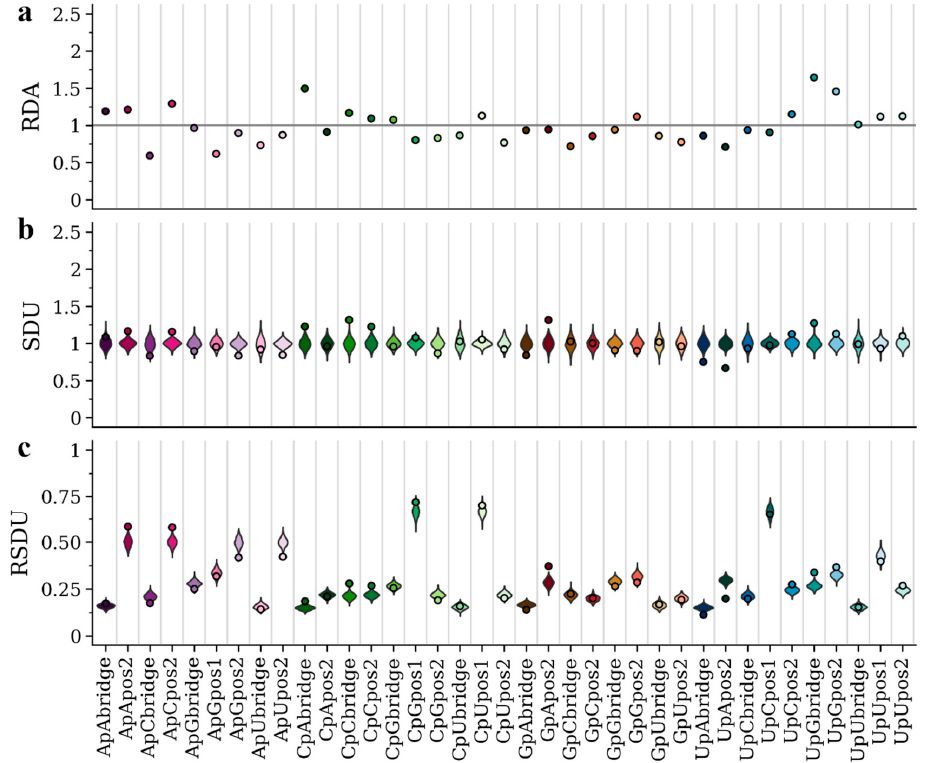
Figure 3. RDA ( a ), SDU ( b ) and RSDU ( c ) values for all informative dinucleotides and frame positions plotted for the AEFV coding sequence. Dot points indicate observed values and violin plots indicate SDU / RSDU error distributions around the null hypothesis (1000 random samples for each value). The grey horizontal line indicates an RDA of 1. Position 1 of dinucleotides CpC, CpA, GpC, GpG, GpU, GpA, UpG, UpA, ApC, ApU, ApA are excluded because they can only produce one amino acid (non- informative).